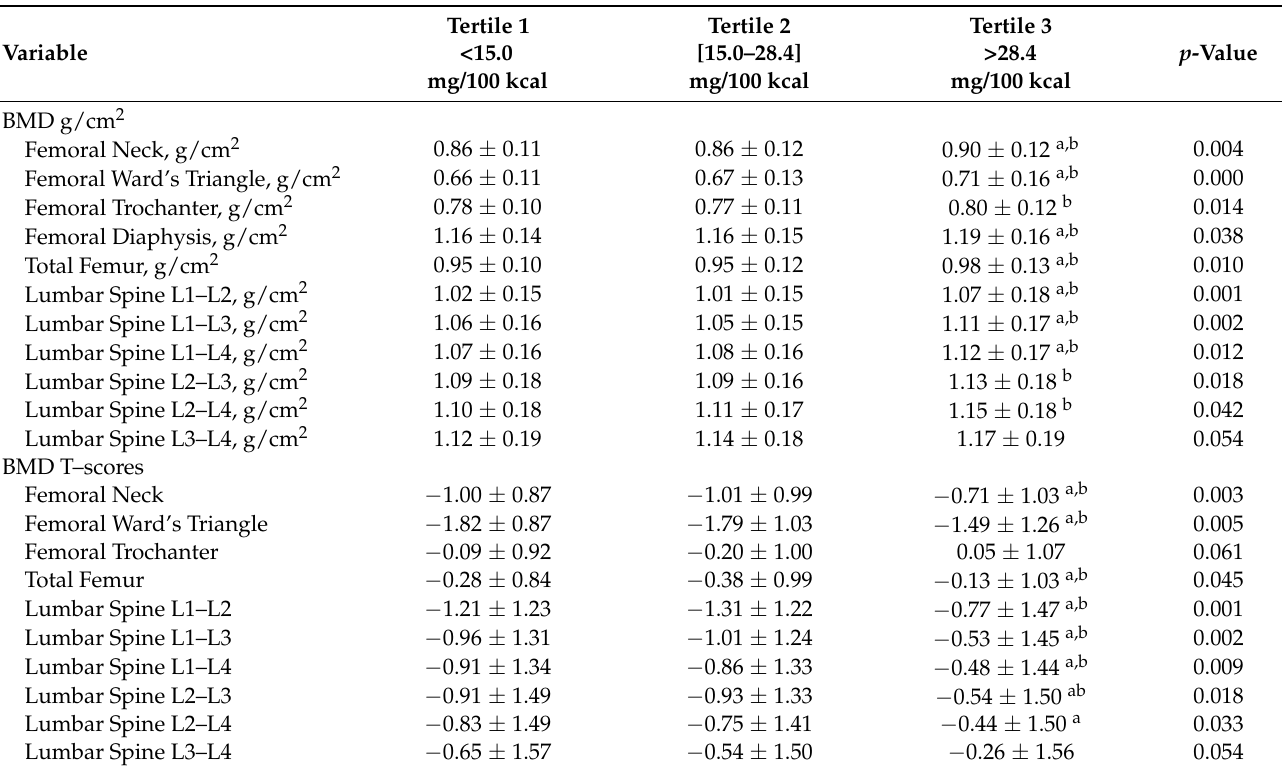
Table 3. Bone mineral density values (g/cm 2 and T-score) according to tertiles of estimated phytate intake (mg/100 kcal ·